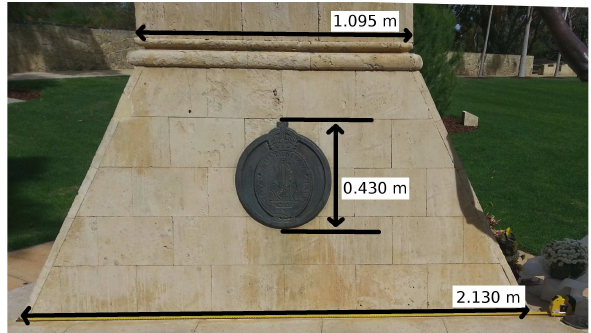
Figure 3: Illustration of the three measurements made on the war memorial dataset. Measurements numbered one to three from top to